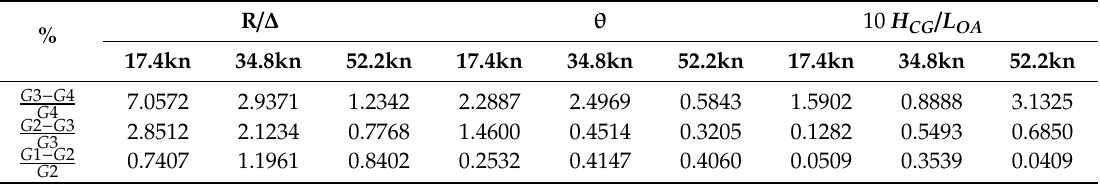
Figure 9. Mesh generation strategy and mesh convergence study for full-scaled numerical simulation: ( a ) Total number of grids; ( b ) Resistance; ( c ) Trim angle; ( d ) Sinkage. Table 3. Mesh generation strategy and mesh convergence.